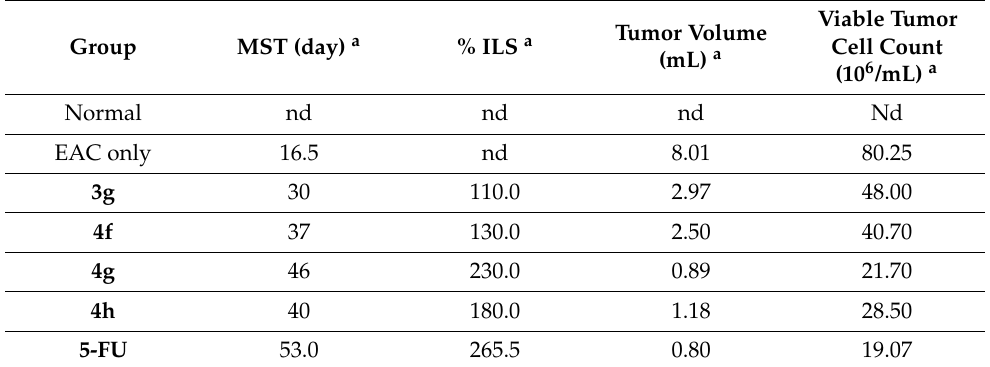
Table 2. Effect of treatment by compounds 3g , 4f , 4g , and 4h on MST, % ILS, tumor volume, and viable tumor cell count in EAC tumor bearing mice.